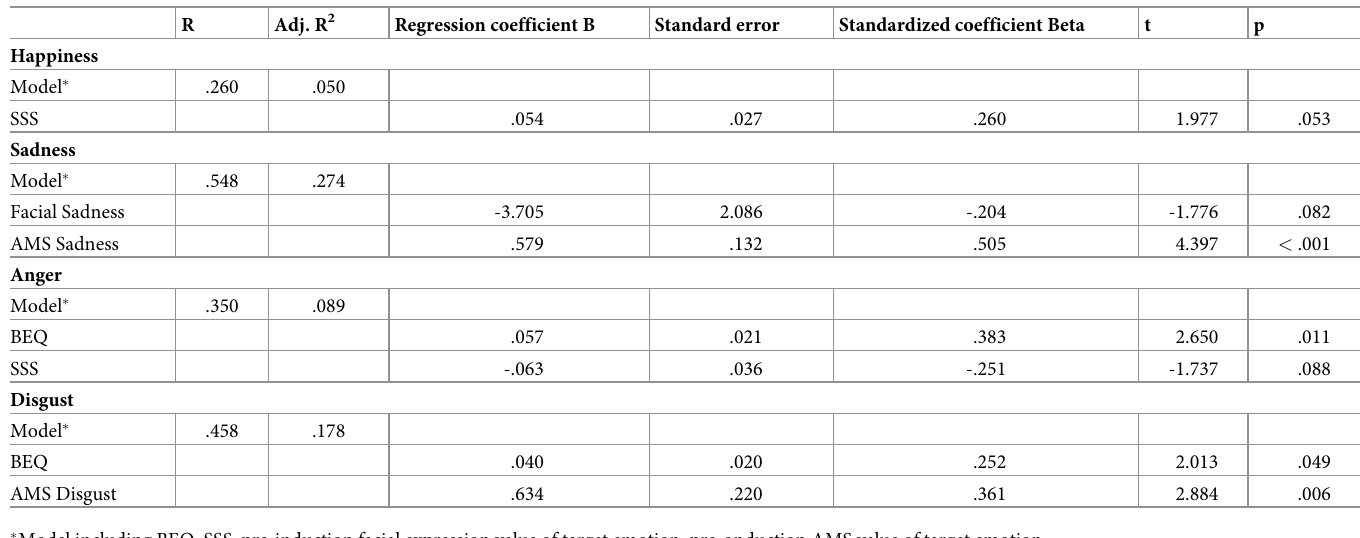
Table 4. Regression model for subjective emotion after corresponding emotion